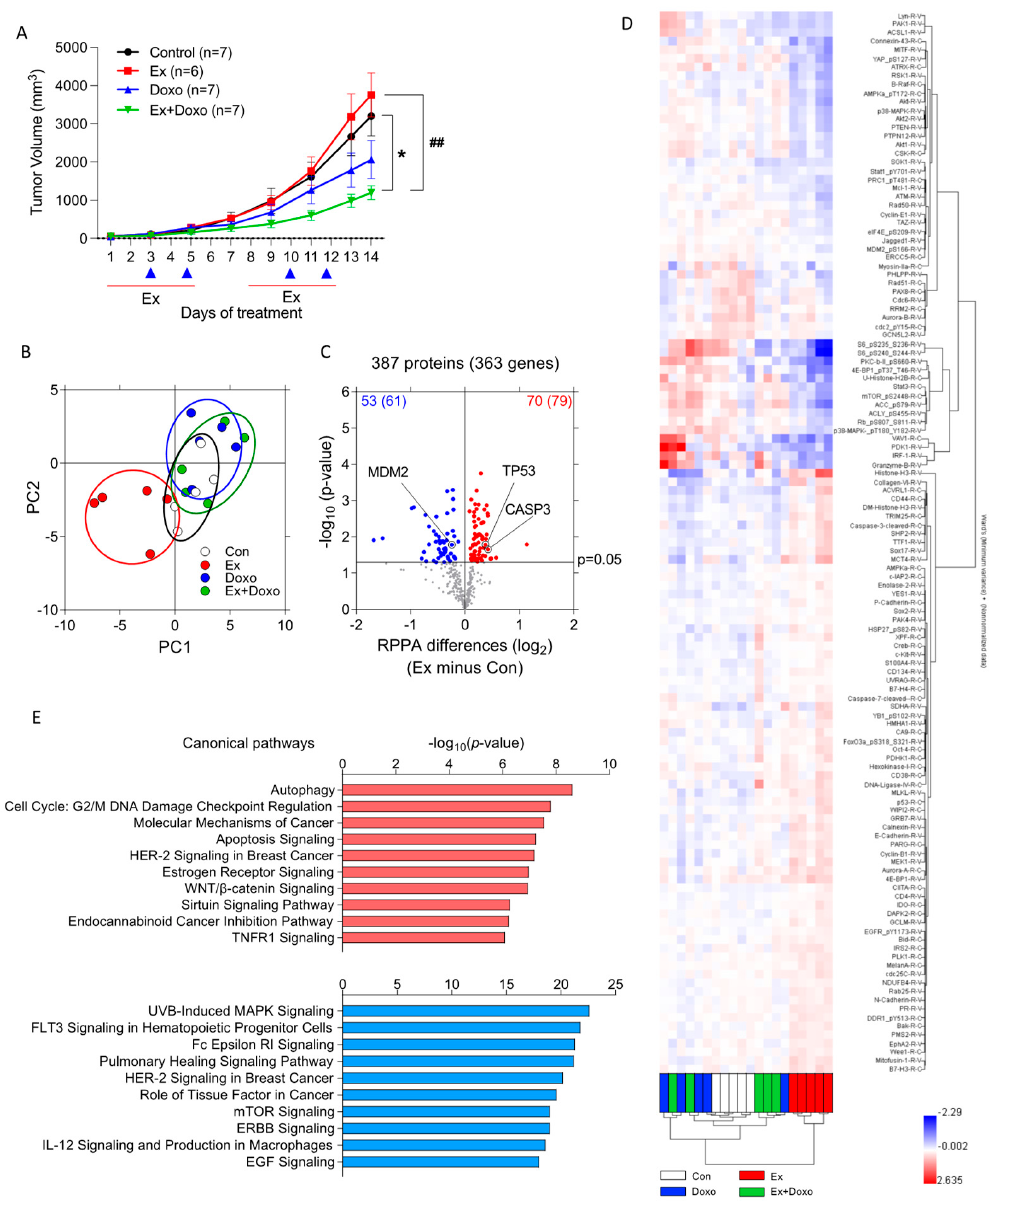
Figure 1. Exercise changes numerous signaling pathways in B16F10 tumors. ( A ) B16F10 tumor volume was measured by caliper over time in mice treated with exercise (Ex), doxorubicin (Doxo), Ex plus Doxo (Ex + Doxo), or no exercise (Con) ( n = 6 or 7 tumors per group). Red line and blue triangle indicate the day(s) that mice were treatment with exercise and(or) doxorubicin, respectively. Data are shown as mean ± SEM. * p < 0.05 vs. Con, ## p < 0.01 vs. Ex. ( B – D ) RPPA was performed on B16F10 whole-tumor homogenates from Ex, Doxo, Ex + Doxo, or Con mice ( n = 5 tumors per group). ( B ) Principal component analysis (PCA) summarized different protein signatures from 387 proteins among groups. ( C ) A volcano plot analysis identified significantly increased (red, n = 70) and decreased (blue, n = 53) proteins in B16F10 tumors from Ex mice compared to tumors from Con mice. The number following the protein numbers indicates the predicted number of changed genes based on RPPA data. The horizontal line indicates p -value at 0.05. ( D ) Hierarchical clustering was performed using the 123 significantly changed proteins or protein modifications from the comparison between Ex and Con. ( E ) An Ingenuity Pathway Analysis determined the top 10 upregulated (red) and downregulated (blue) canonical pathways in tumors from Ex relative to Con mice.